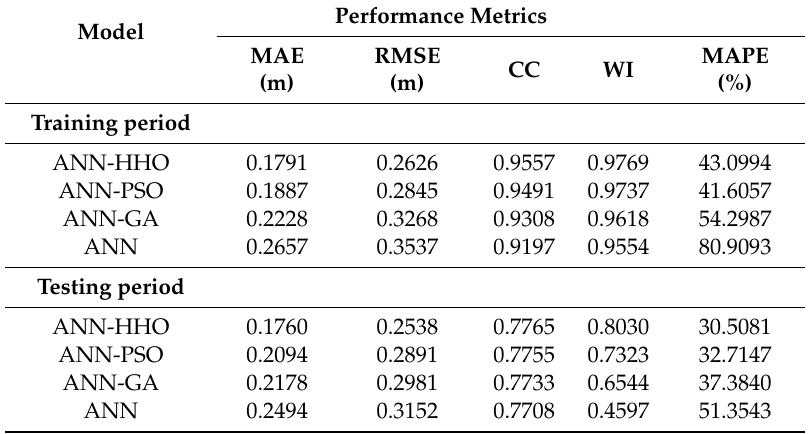
Table 4. Performance metrics of hybrid and simple ANN models during training and